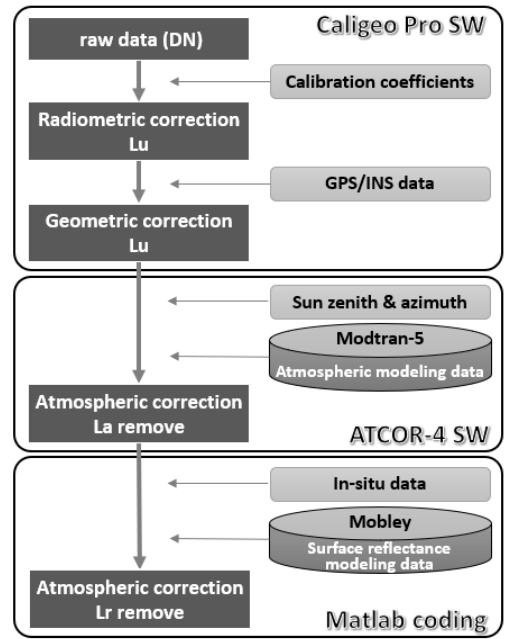
Figure 5 . Flowchart of the data processing procedures used on the hyperspectral scanning data.